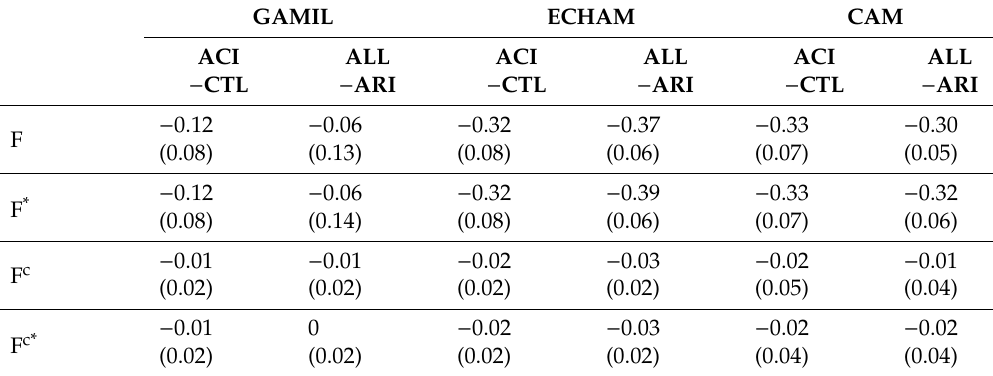
Table 5. Same as Table 3, but shown are changes from aerosol-cloud interactions (i.e., the ACI experiment minus the CTL experiment and the ALL experiment minus the ARI experiment). GAMIL ECHAM GAMIL